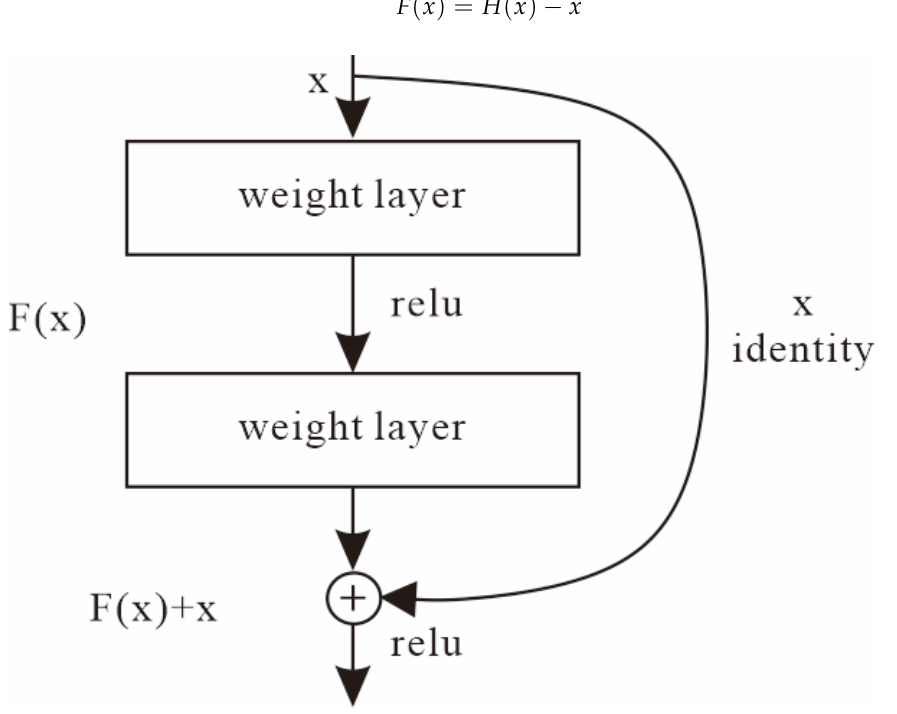
Figure 2. Residuals of ResNet50